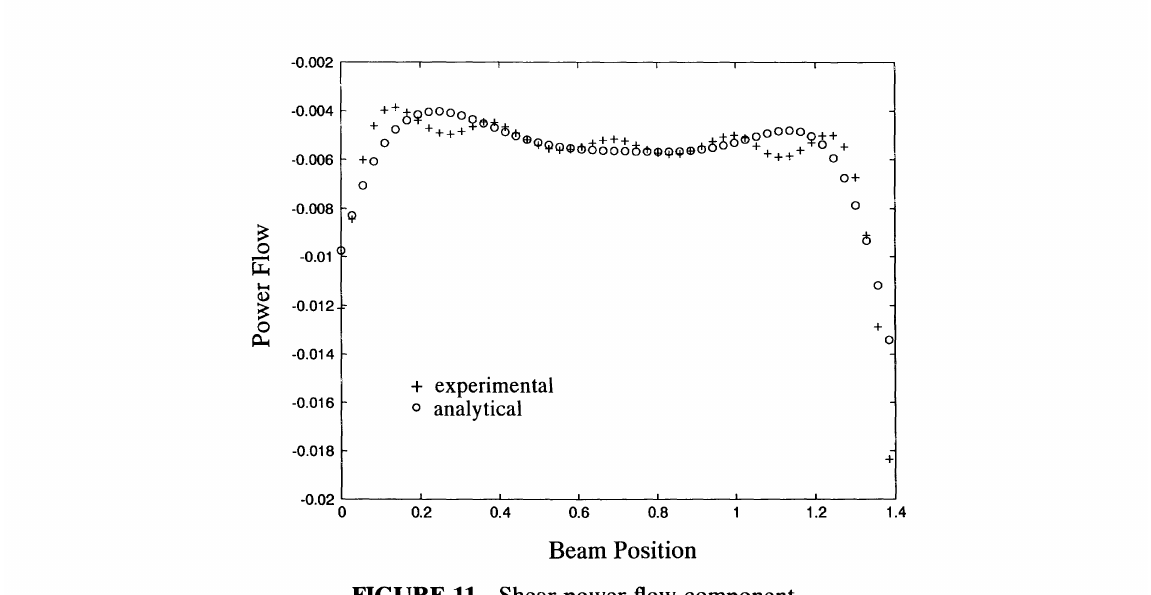
FIGURE 11 Shear power-flow